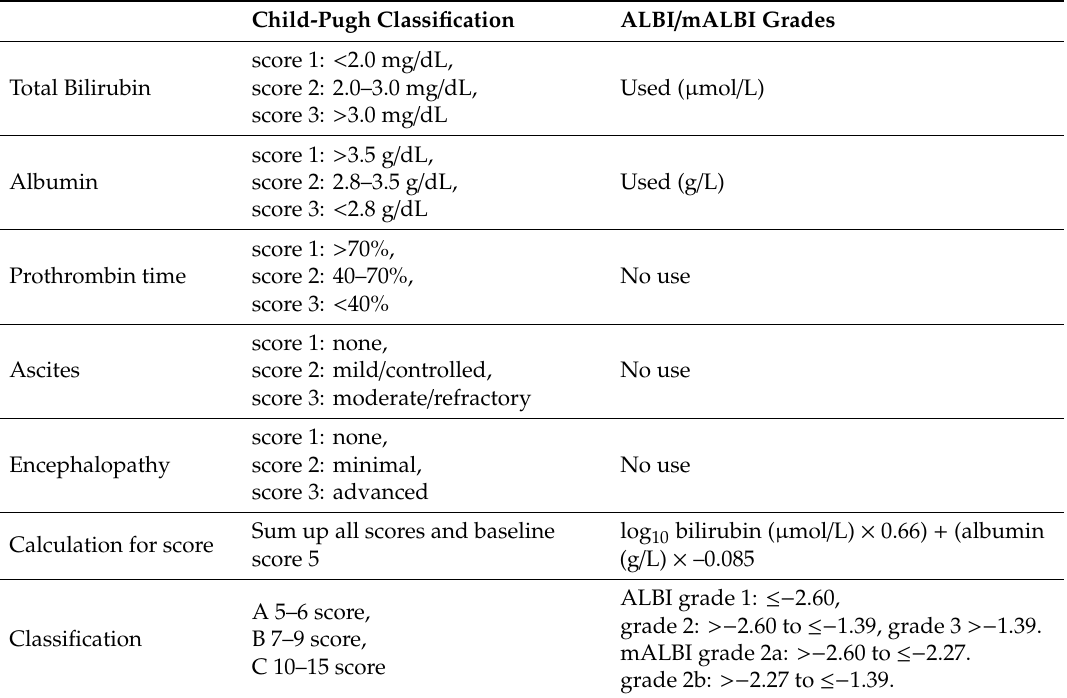
Table 1. Comparisons of the Child–Pugh classification with ALBI and mALBI